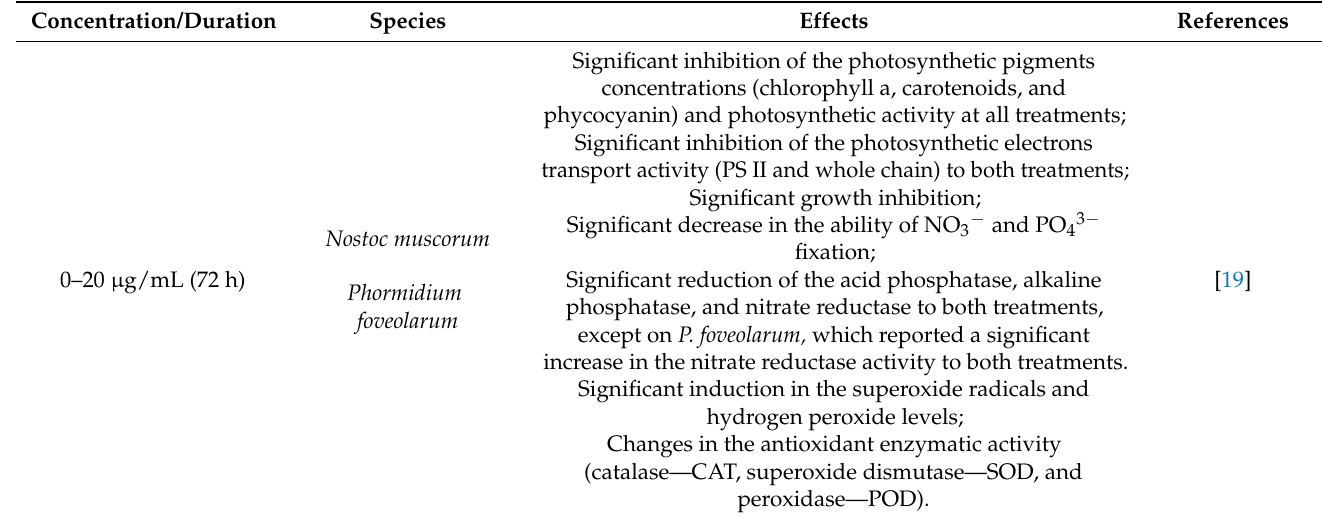
Table 2. Effects of the oxyfluorfen on freshwater species evaluating parameters, such as growth inhibition, photosynthetic and enzymatic activities, and fatty acids